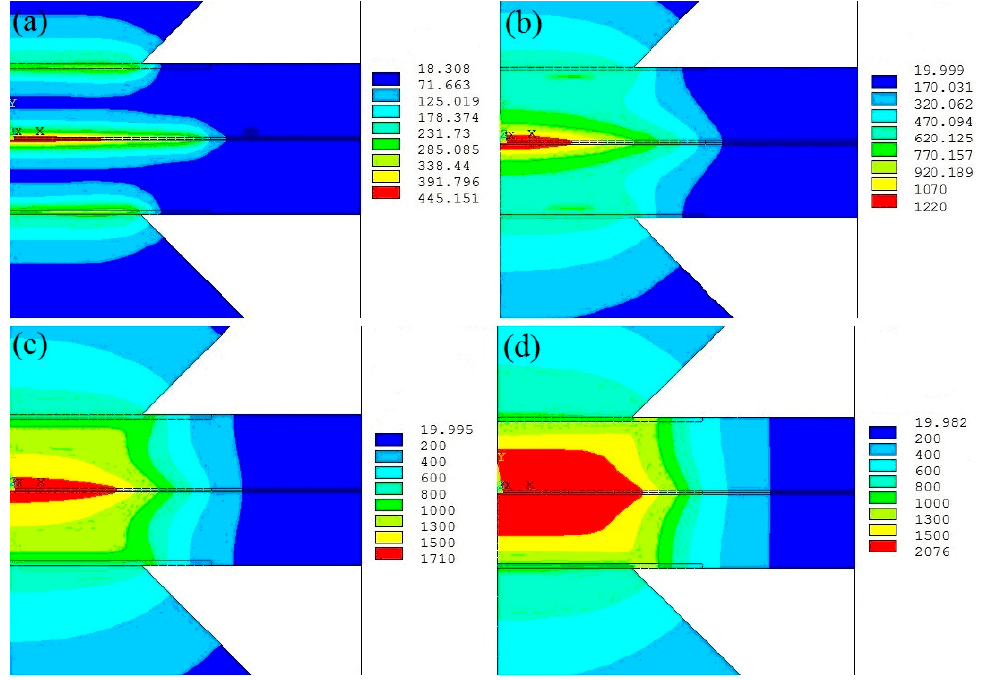
Figure 11. Temperature profile of the welding zone in the welding process ( a ) 0.007 s, ( b ) 0.05 s, ( c ) 0.13 s, and ( d ) 0.28 s.